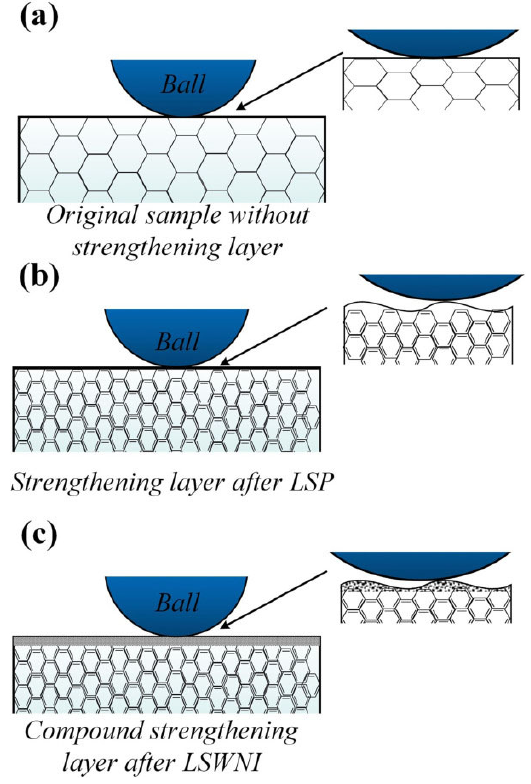
Figure 10. Wear model ( a ) untreated specimen, ( b ) LSPed specimens, and ( c ) diamond nanoparticle implanted using LSP specimens [102].